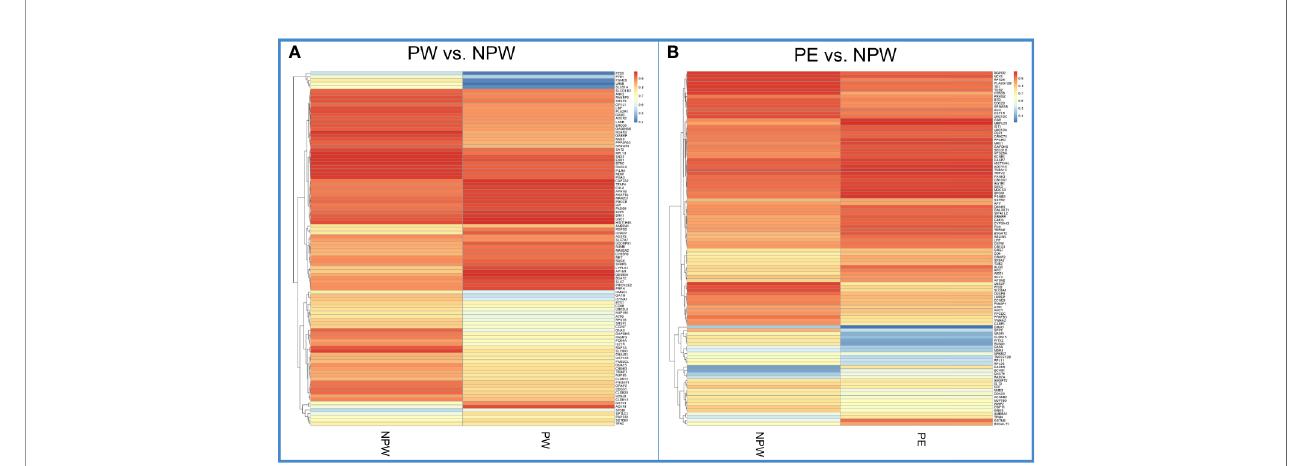
FIGURE 6 | Heatmap of methylation levels of signi fi cant DMGs in each KEGG pathway in the PW and PE groups. (A) Methylation levels of the signi fi cant DMGs in 201 KEGG pathways in the PW and NPW groups. Blue color represents lower methylation levels. Red represents higher methylation levels. (B) Methylation levels of the signi fi cant DMGs in 196 KEGG pathways in the PE and NPW groups. Blue color represents lower methylation levels. Red represents higher methylation levels.